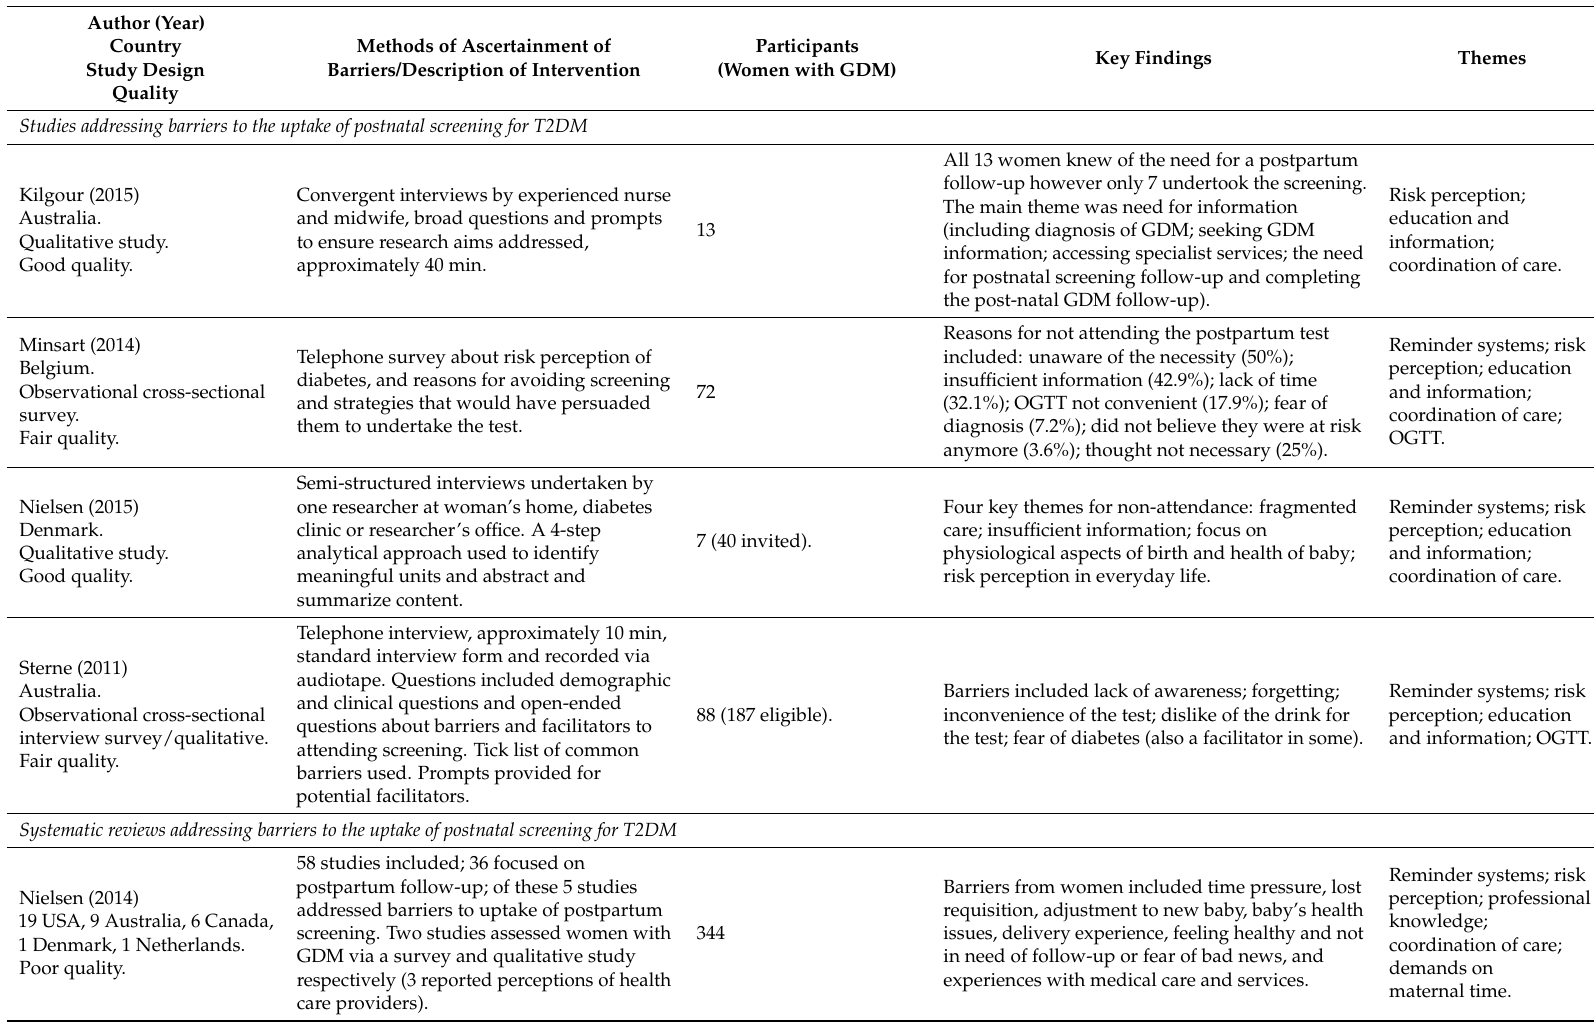
Table 1. Characteristics of included primary studies and systematic reviews ( n =